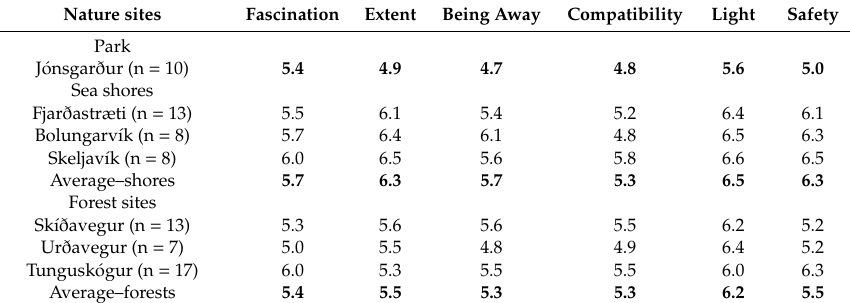
Table 2. Results from the questionnaire on the perception of the environment.